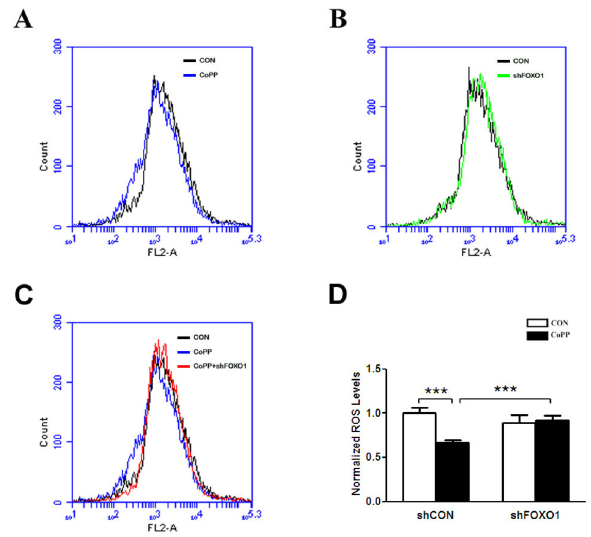
Figure 6. CoPP extenuates mitochondrial ROS production which is mediated by FOXO1. Primary hepatocytes are plated in six-well plates. Cells are infected by shFOXO1 virus or control virus. After 24h, cells are exposed to 10 μM CoPP or DMSO for 18h. And cells are trypsinized and harvested, then are loaded with MitoSOX Red for 10 minutes in the dark at 37°C. Next, cells are washed twice with PBS and fluorescence is measured using flow cytometry. Mitochondrial ROS levels are expressed as the mean ± s.d. intensity of cell fluorescence. ***p < 0.001 .